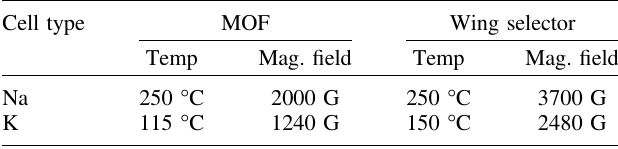
Table 2. Operative temperatures of the MOFs used in the SAMM telescope.